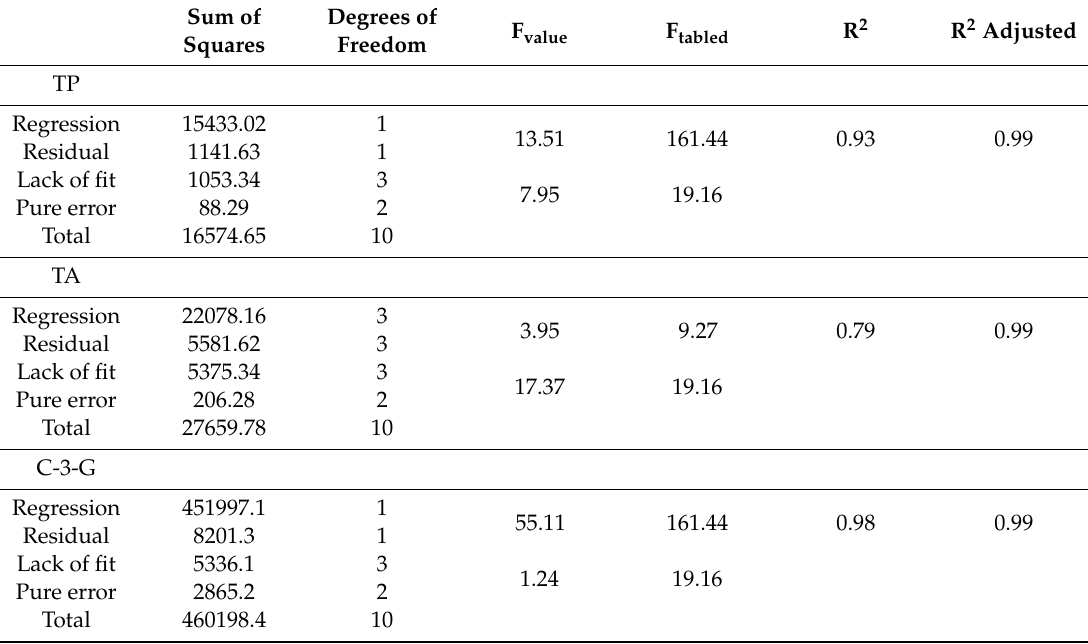
Table 2. ANOVA for TP, TA, and C-3-G from jaboticaba